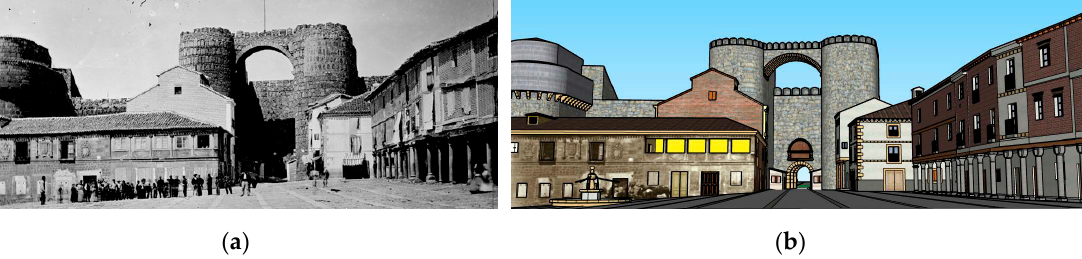
( c ) Figure 9. Intramural buildings: different views of the CAD (Computer-Aided Design) modeling of Alcázar previous to the mid-18 th century: ( a ) southeast view; ( b ) southwest view; ( c ) interior detail from the northwest viewpoint. [1]. 3.3. Extramural B uildings On the basis of the 4D modeling of the current remains, the reconstruction process was carried out based on several photographic sources, which considerably reduced the uncertainty associated with the final 4D model. The reconstruction process was similar to that described in subsection 3.2, with the most remarkable difference caused by the nature of the historical source, which in this case was old photographs. The first issue was that the extramural buildings disappeared, and there were no current remains. The only anchor elements were the walls, which will be used to estimate the photographs’ scale. Secondly, the historical images had vanishing points, and their identification was necessary in order to carry out the reconstruction [24]. The modeling was carried out in two phases; the first was the coarse modeling of building blocks as idealized prisms (e.g. orthogonality between façades, round angles, etc.). They were scaled on the basis of the identifiable elements of the wall. The older the photograph, the higher the uncertainty due to the changes suffered by the wall, especially by the rehabilitation and conservation interventions. For the older images, the distance between some stones was employed, which allowed a reasonable reconstruction of the 4D model. For the most representative extramural building, the Alhóndiga , the old photographs were used to vectorize and reconstruct the façade (e.g. elements doors, windows, columns, etc.). The vanishing points and vanishing lines were used to rectify the images, and therefore enabled the possibility of